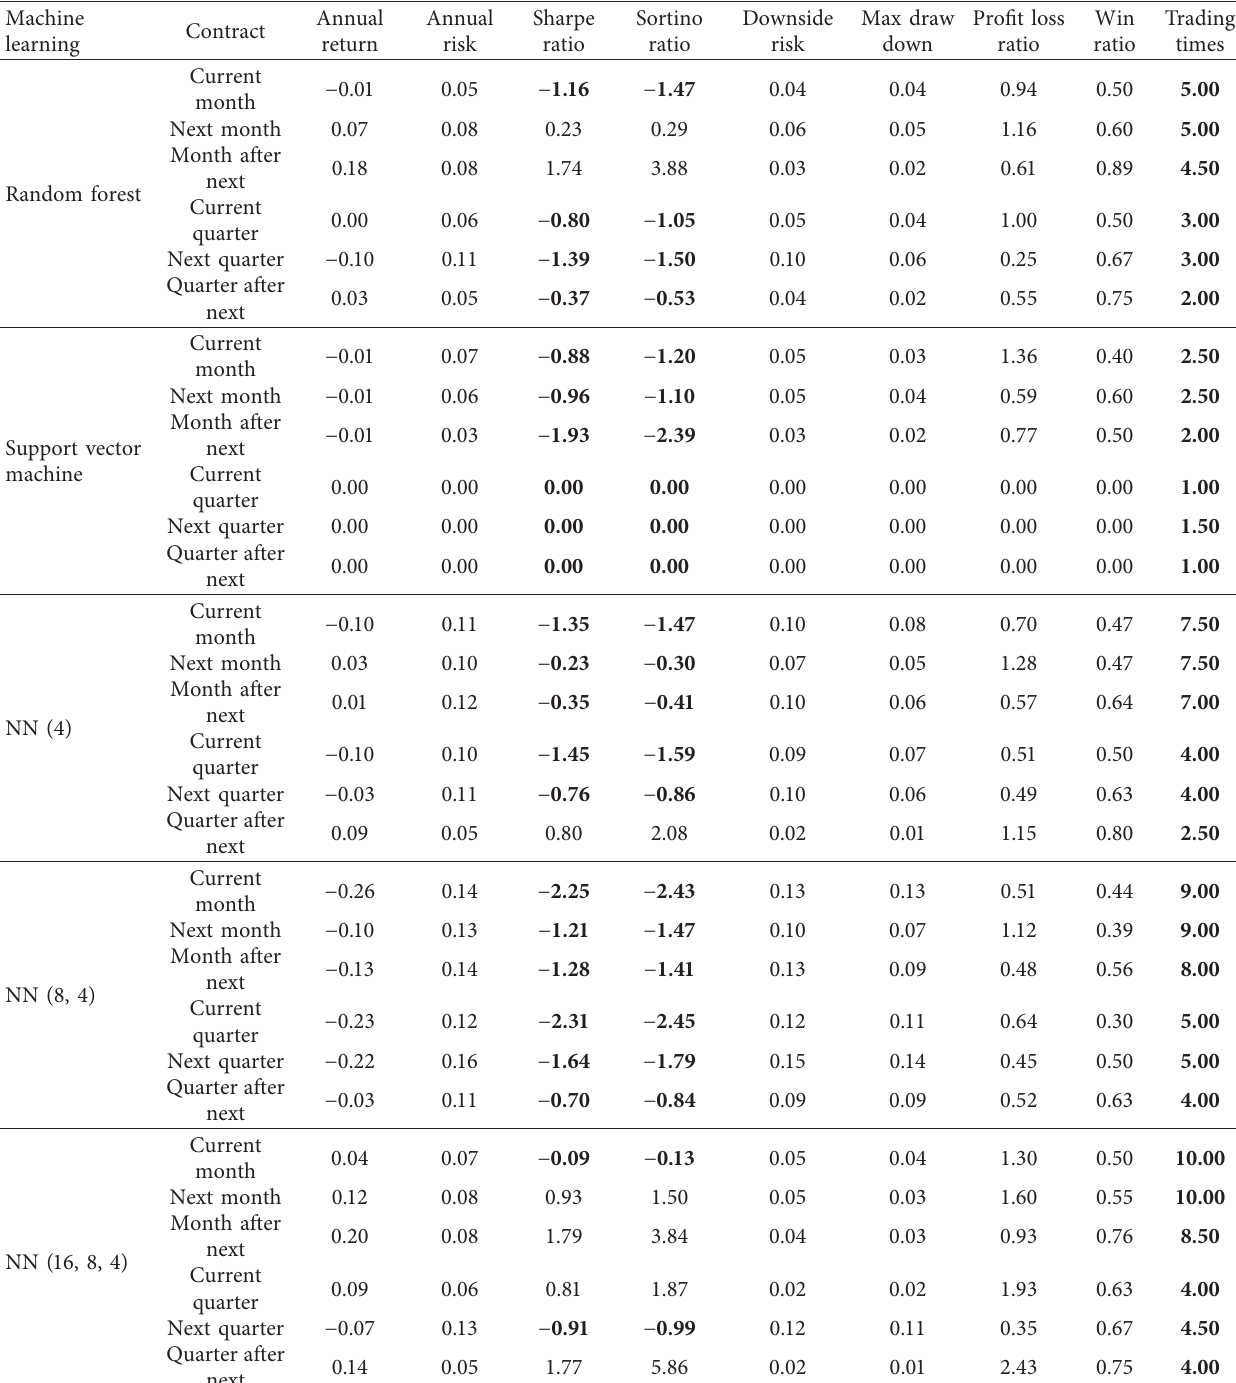
Table 16: Option strategy of predicting the rise and fall of volatility by threshold (use 12 features M2, threshold � 0.7). Machine